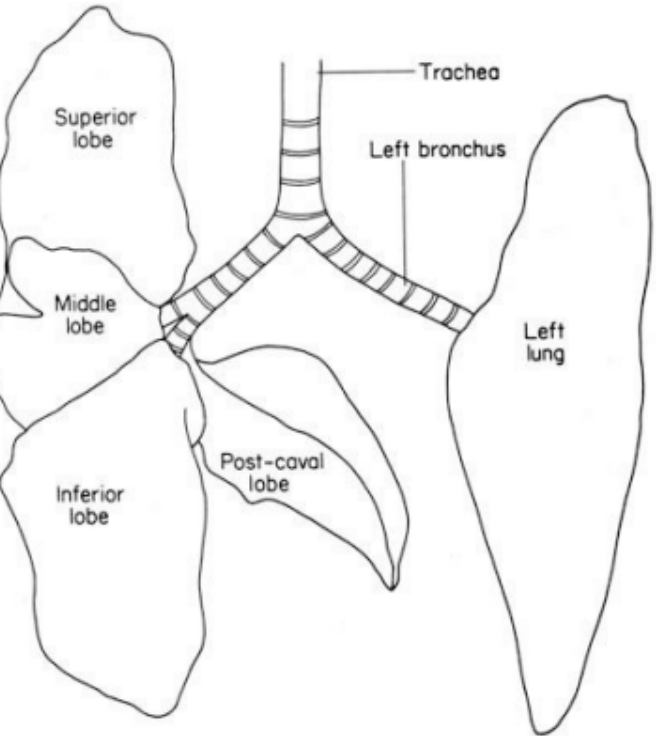
Figure 1. Rodent trachea and lungs (adapted from Figure 2 of OECD GD 39 [11]). Superior lobe (RC, right cranial); middle lobe (RM, right median); inferior lobe (RCa, right caudal), and post-caval lobe (RA, right accessory). Table 3. Lung deposition of 5-day subacute inhalation exposure for soluble silver nanoparticles (AgNP, 20 nm) and insoluble gold nanoparticles (AuNP, 11 nm). Park et al. [7] and Kim et al. [8].